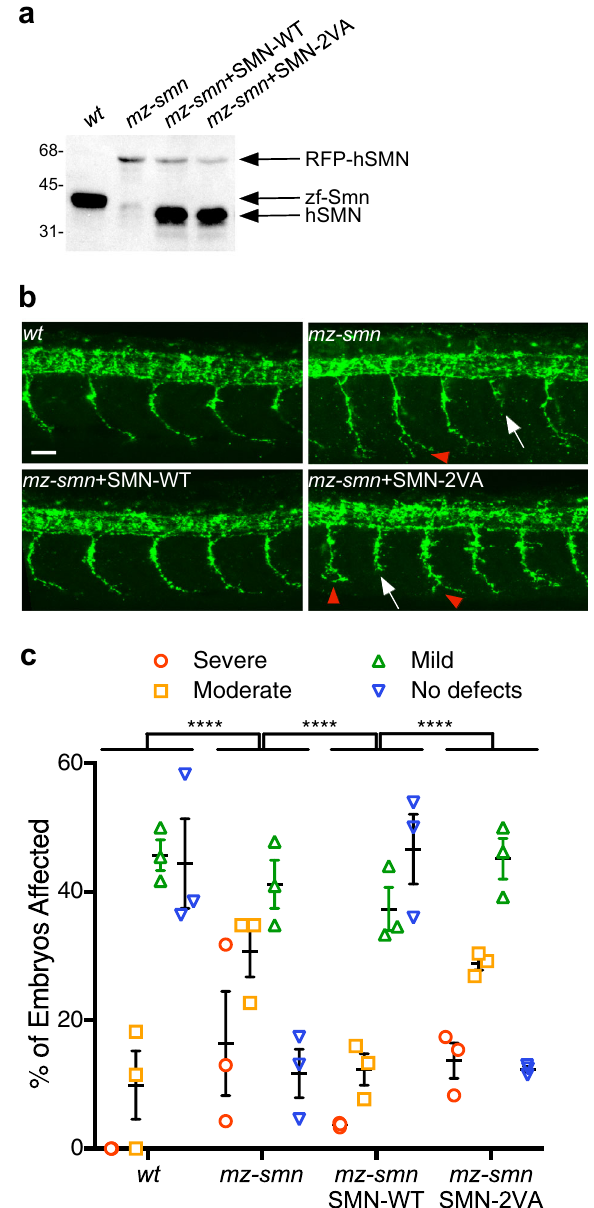
Fig. 5 SIM-less SMN fails to rescue motor axon de fi cits in a zebra fi sh model of SMA. a 250 pg of WT or 2 VA human SMN RNA was injected into one-cell stage mz-smn mutants zebra fi sh embryos and western blot analysis showed that both WT and mutant SMN protein are expressed at comparable levels. b Representative images of motor neuron phenotype for each group. Scale bar 50 μ m. Truncated motor axons (white arrows) and branched motor axons (red arrowheads) occur, in relation to SMN levels reduction, with increasing degrees of severity determining the classi fi cation in one phenotypic class. c Animals were scored as having severe, moderate, mild or no defects in their motor axons at 28 h post fertilization (hpf). Data represent means and SEM. Three independent experiments were performed with 14 – 21 animals per experiment. Statistics were performed with two tailed Mann – Whitney non-parametric rank test (wt vs mz-smnp p < 0.0001; wt vs mz-smn + WT RNA p = 0.865; wt vs mz-smn + 2 VA SMN RNA p < 0.0001; mz-smn vs mz-smn + WT SMN RNA p < 0.0001; mz-smn vs mz-smn + 2 VA SMN RNA p = 0.624; mz-smn + WT SMN RNA vs mz-smn + 2 VA SMN RNA p <